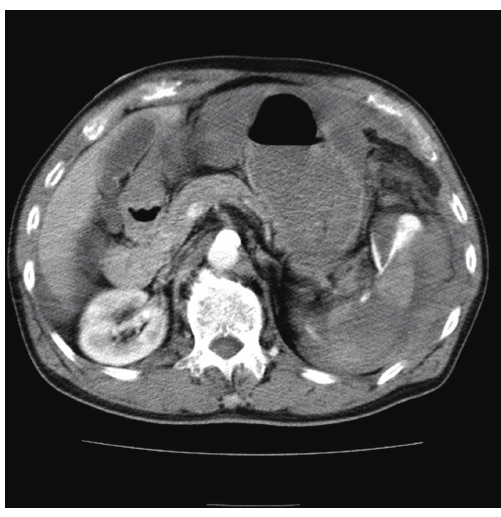
Figure 1: Transverse plane of helical CT of abdomen with IV contrast shows extravasation at splenic hilum and fluid around spleen.